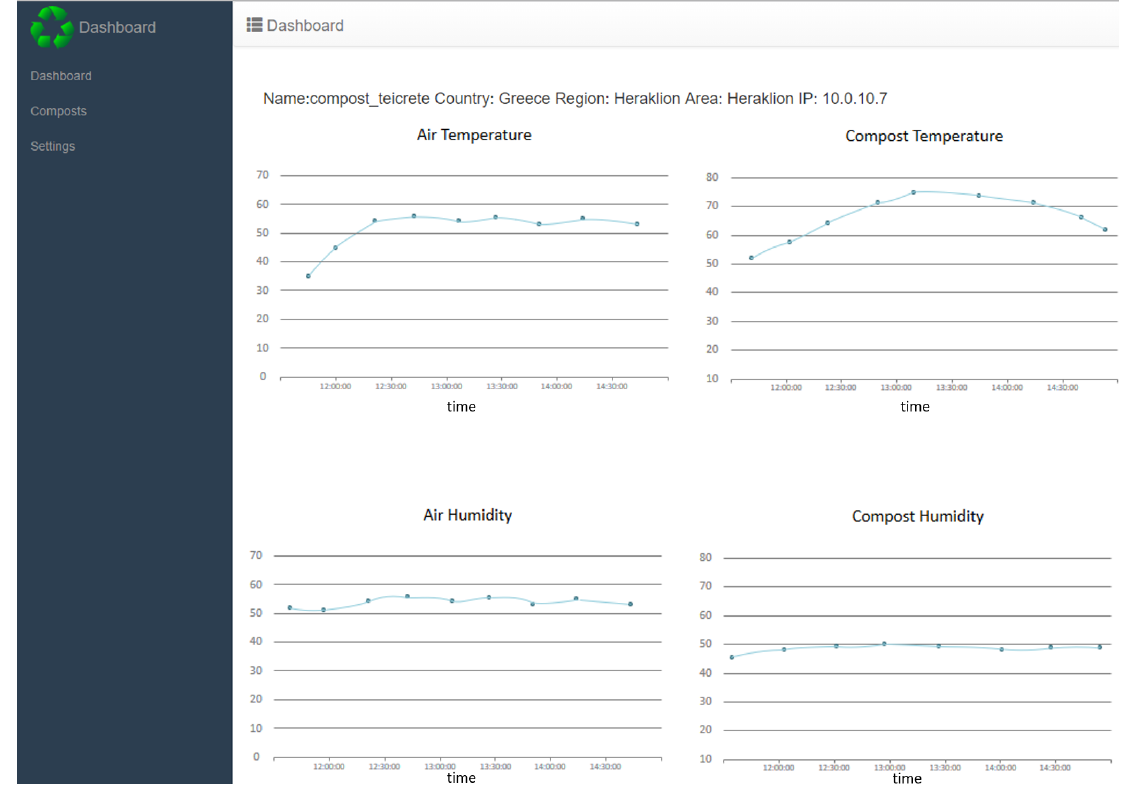
Figure 10. Real-time sensor